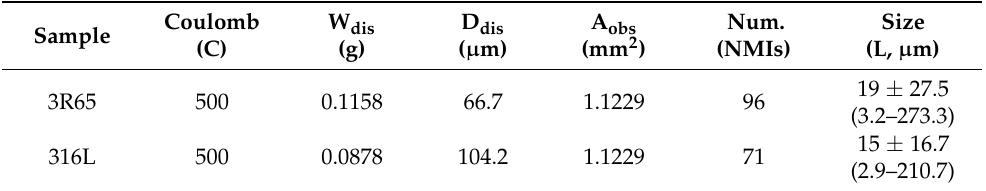
Table 3. Main parameters of electrolytic extraction (EE) and scanning electron microscopy (SEM) observation of Nonmetallic inclusions (NMIs) in the 3R65 (0.03% C) and 316L (0.02% C) steels when using Method 1.